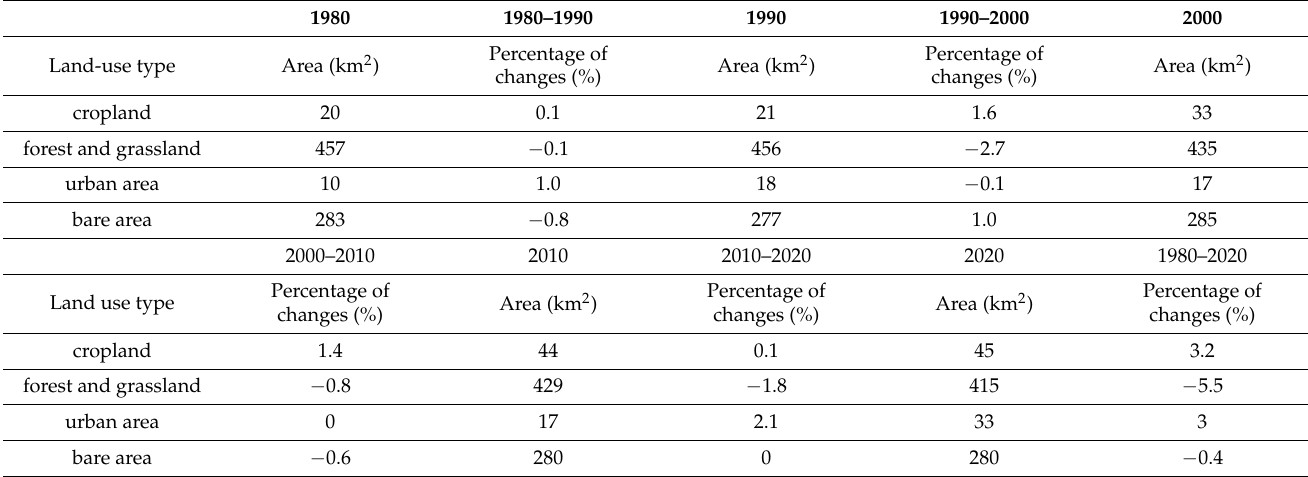
Table 1. The area changes of land use type in 1980 and